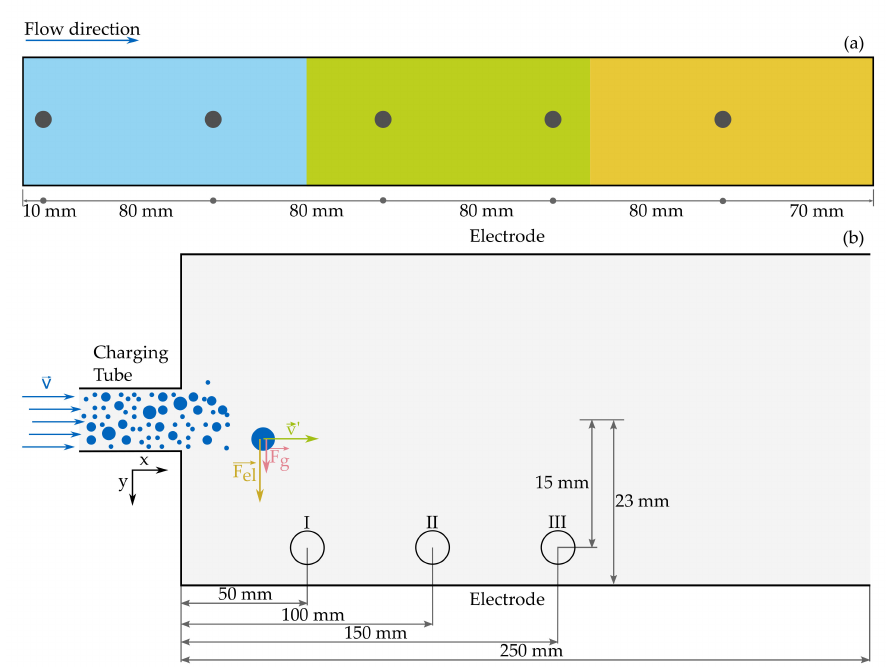
Figure 1. ( a ) Schematic of the sampling points along the electrodes. The powder deposition height on the electrode was measured at the points marked by gray circles. Colored areas mark the areas of powder sampling along the electrode. ( b ) Schematic of the separation chamber and the charging